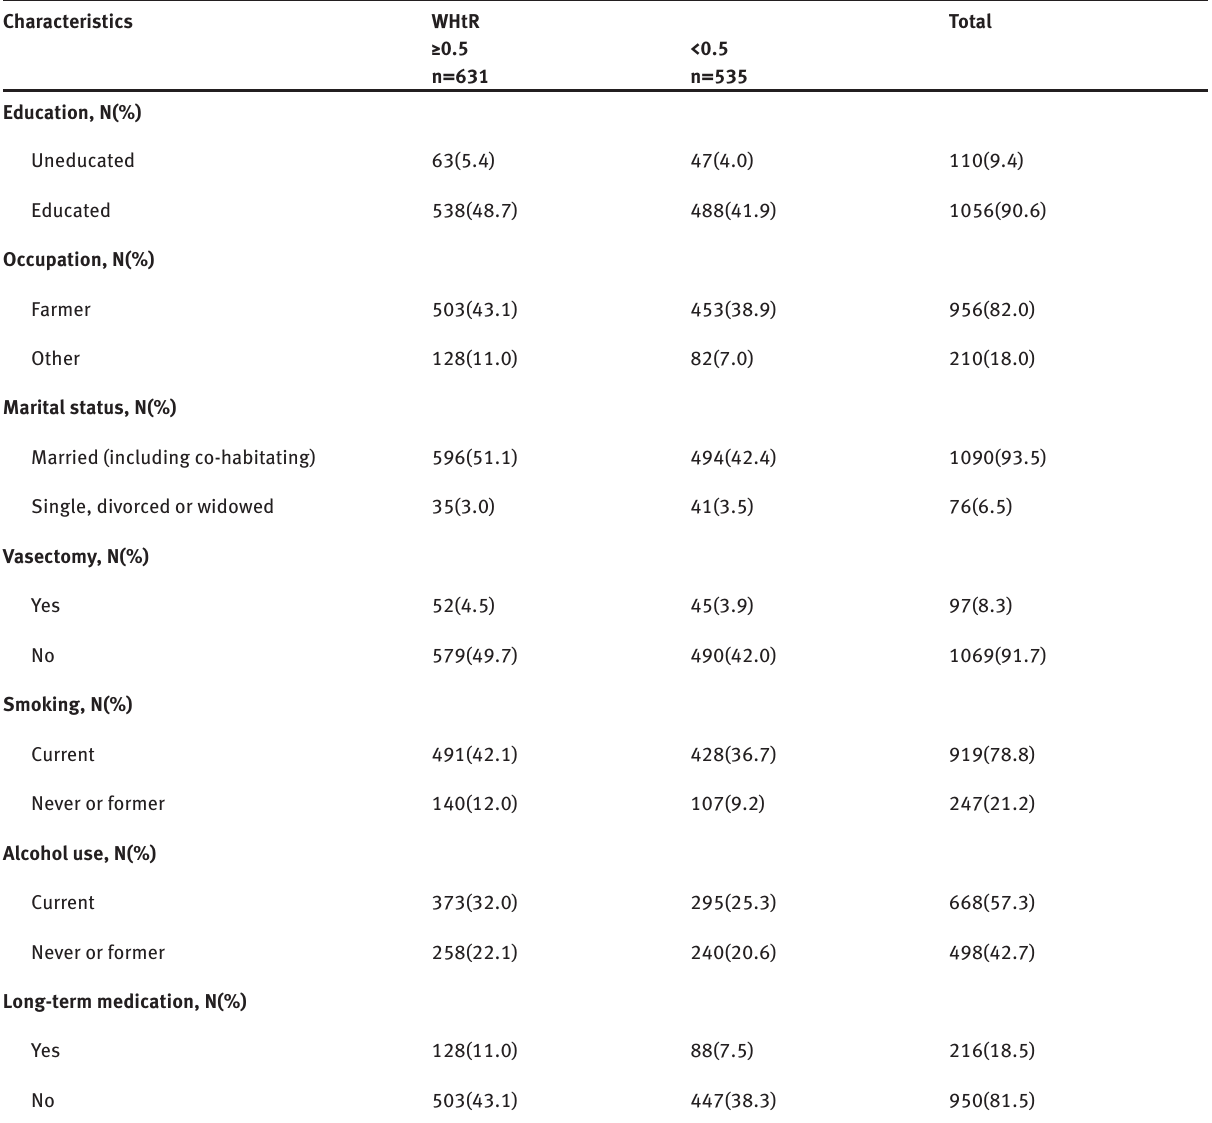
Table 1: Demographic characteristics by WHtR